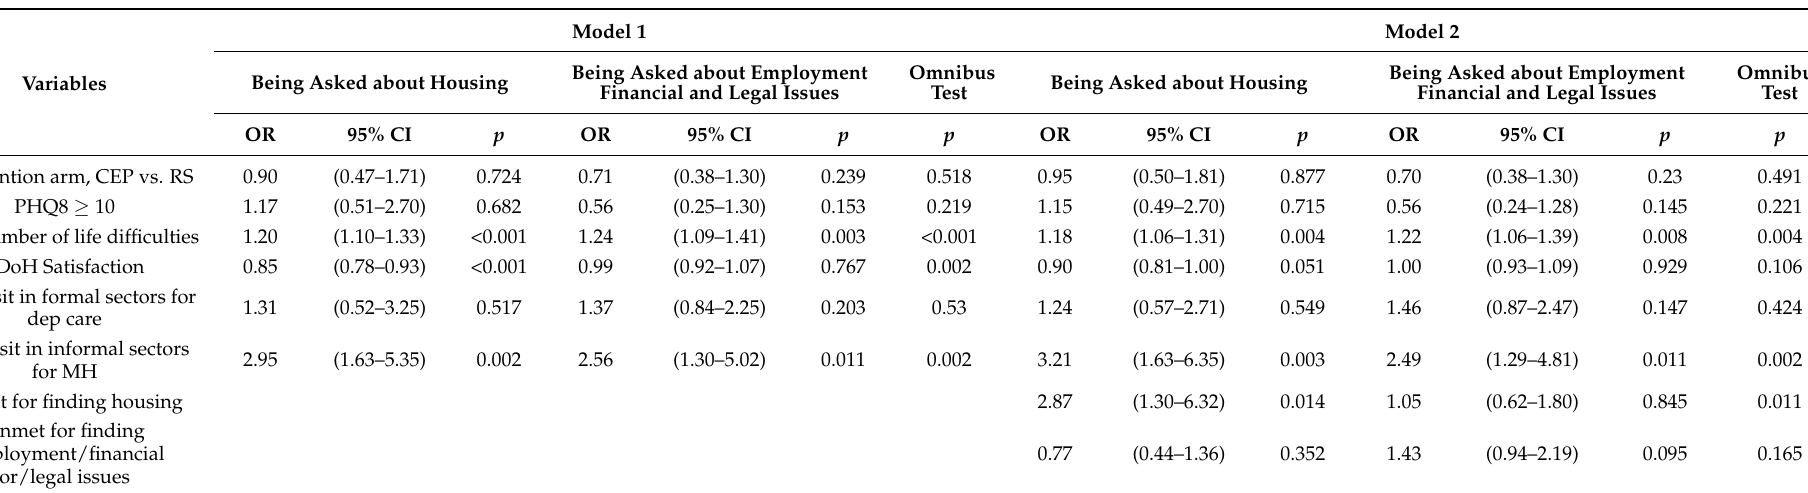
Table A2. Models for being asked about housing and employment financial and legal issues at 36 months, by perceived life difficulties and service utilization controlling for intervention condition